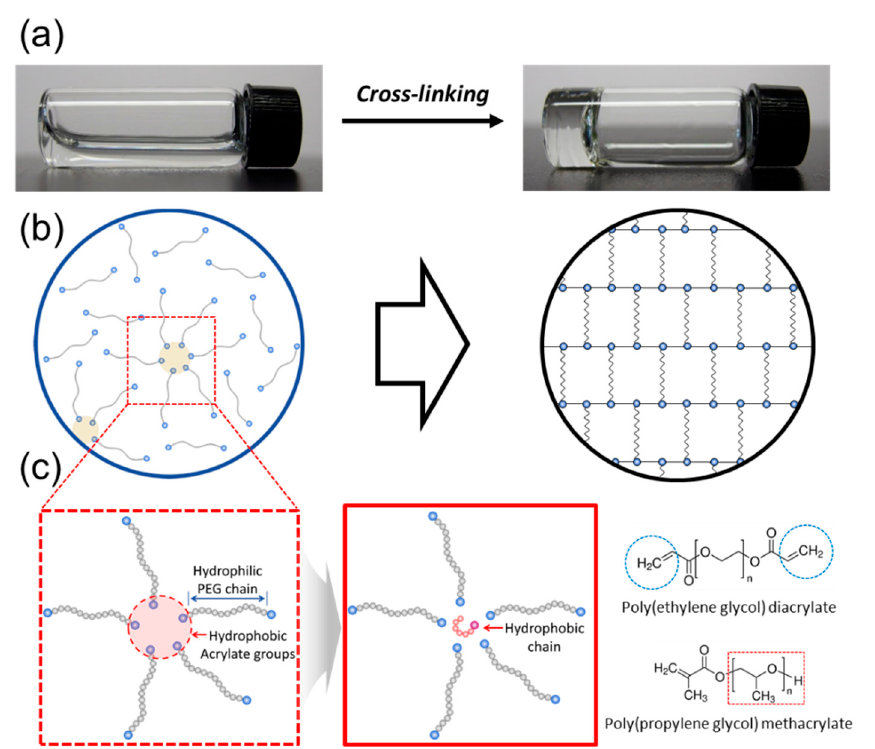
Figure 1. Schematic description of hydrogel forming from polymer cross-linkers in a pre-gelled solution ( a ). The internal structures of self-assemblies associated with polymer cross-linkers in a pre-gelled solution ( b ) and incorporating of hydrophobic chains using the self-assemblies ( c ).